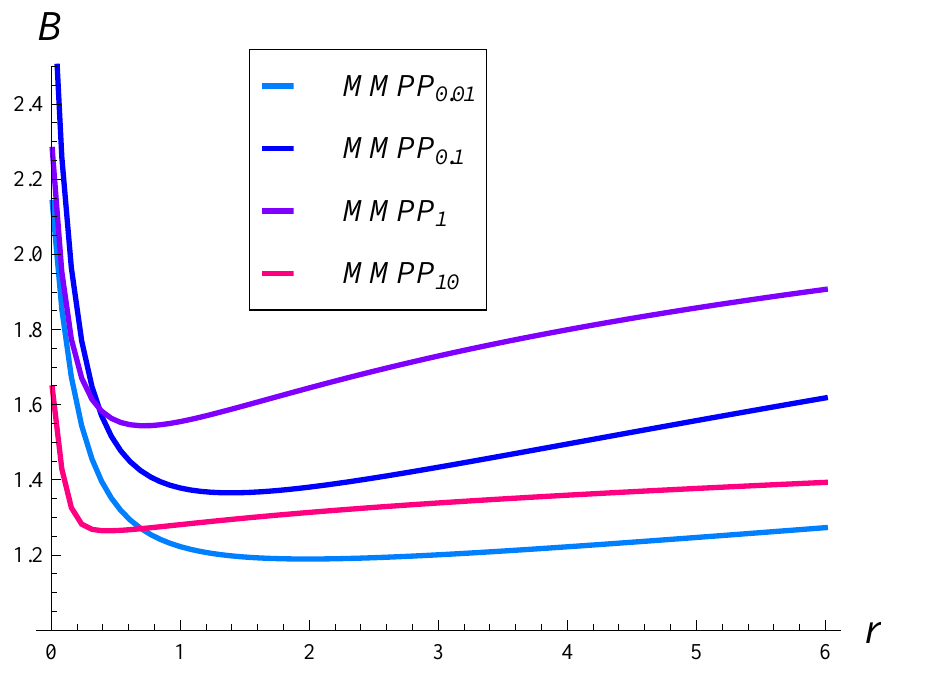
Figure 4. Burst ratio vs. the strength of the drop probability function for arrival processes with different autocorrelations. Link load ρ =